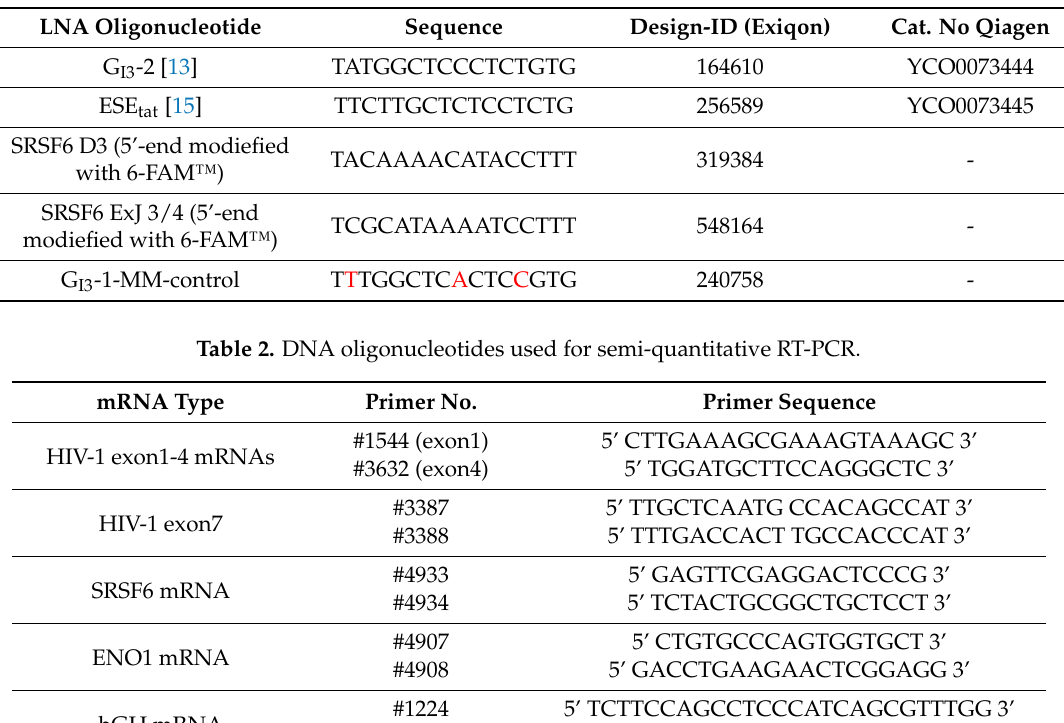
Table 1. LNA/DNA mixmer oligonucleotides used in this work.